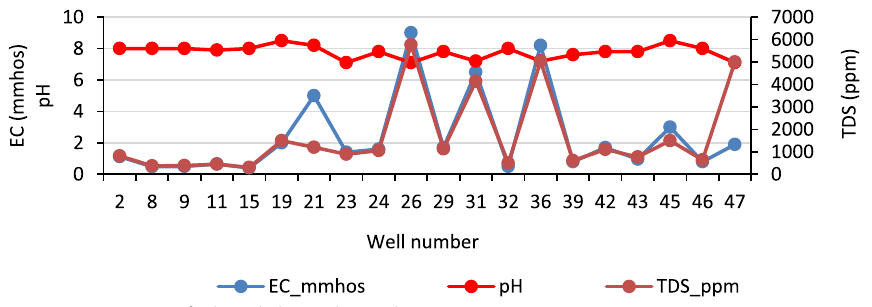
Fig. 5 Concentration of selected physio‑chemical